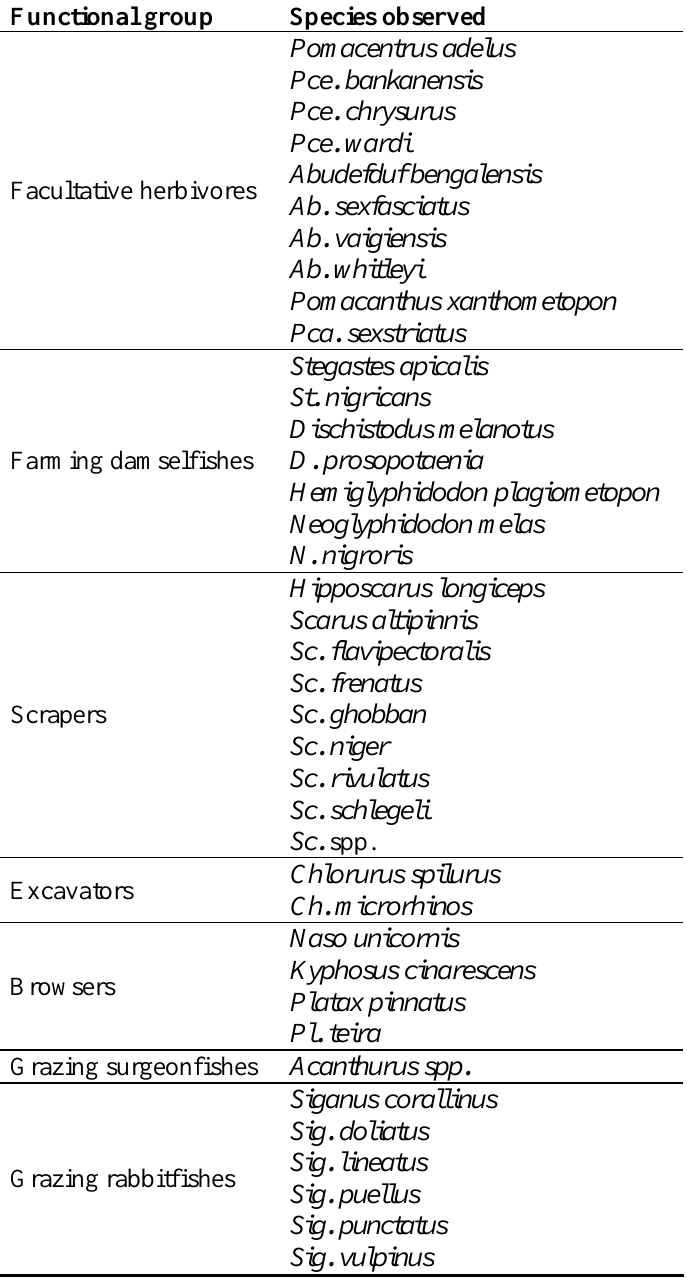
Table A1.1. Functional groups and species assigned to each, observed in Pioneer Bay, Orpheus Island. Facultative herbivores include species that often feed on algae but may have a large dietary component of invertebrates or other prey. These include the primarily invertivorous